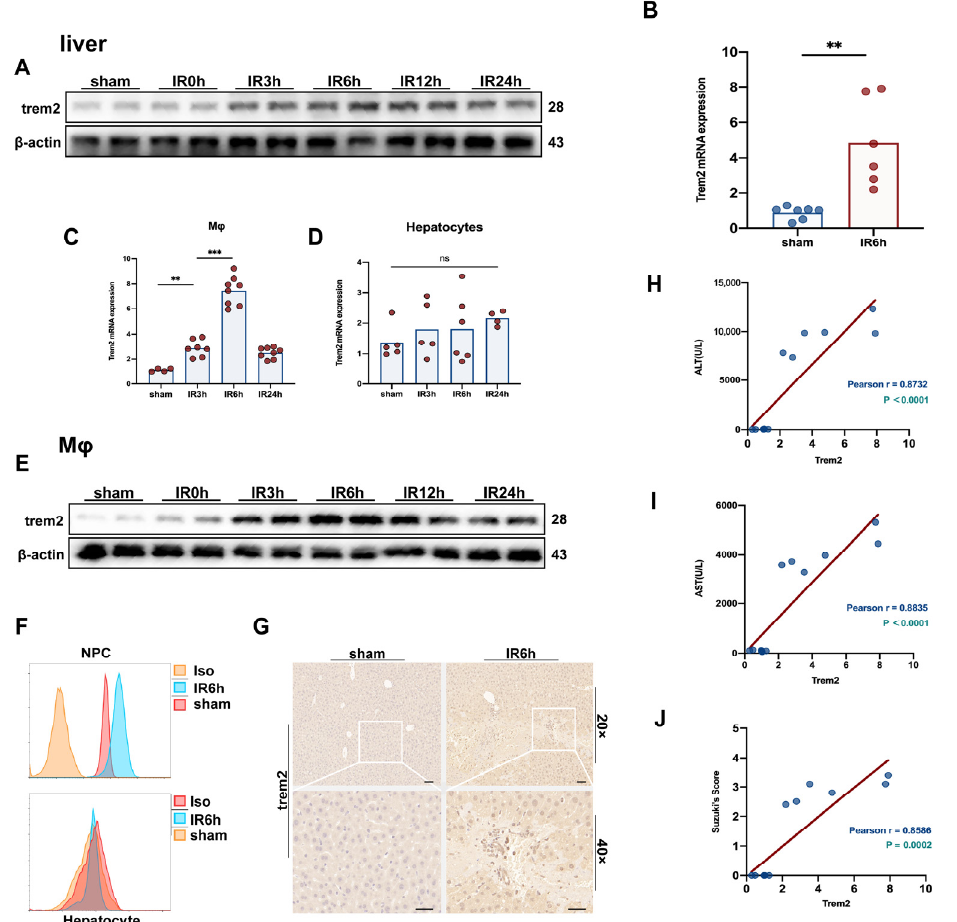
Figure 1. Macrophages Trem2 was activated in the IR liver. The protein and mRNA expression of Trem2 in the liver at different time points after IR was detected by ( A ) Western blot and ( B ) qPCR ( n = 6–7/group, ** p < 0.01); ( C , D ) Trem2 mRNA levels in NPCs or hepatocytes isolated from IR liver were detected by qPCR ( n = 4–8/group, ns = Not Significant, ** p < 0.01, *** p < 0.001); The expression of Trem2 protein in NPC and hepatocyte isolated from IR liver was detected by ( E ) Western blot or ( F ) Flow cytometry. ( G ) The expression of Trem2 was detected by IHC, scale bars = 50 μ m; ( H , I ) Correlation between serum ALT/AST and Trem2 mRNA expression; ( J ) Correlation between liver Suzuki’s score and Trem2 mRNA expression.